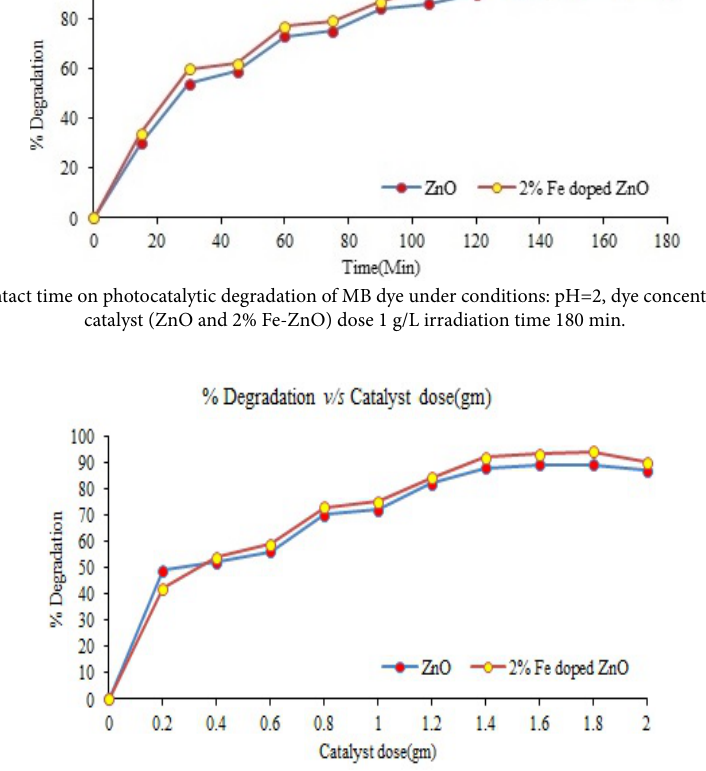
Fig. 9. Effect of catalyst dose on the photocatalytic degradation of MB dye under conditions: pH=2, dye concentration 10 mg/L and catalyst (ZnO and 2% Fe-ZnO) dose 0.2-2 g/L irradiation time 140 min.